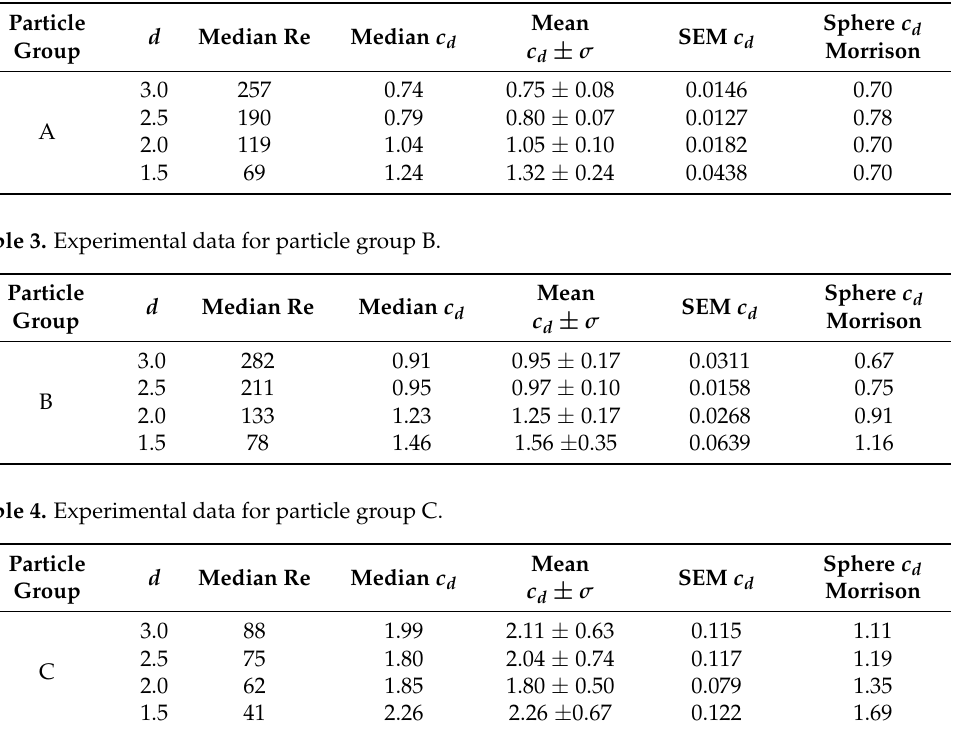
Table 2. Experimental data for particle group A.